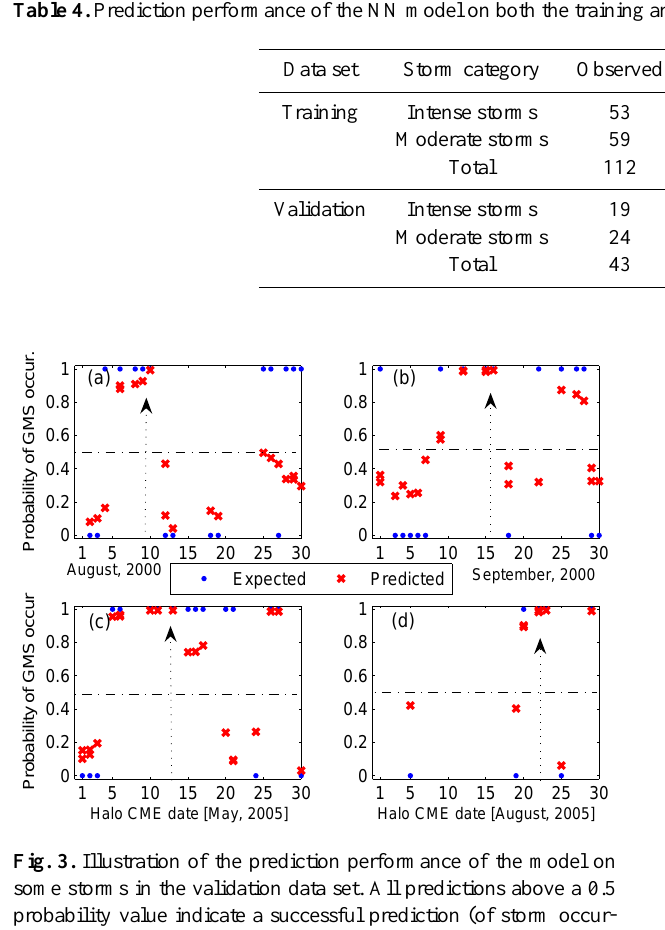
Table 3, and its predicted geoeffectiveness is represented by the arrow in Fig.